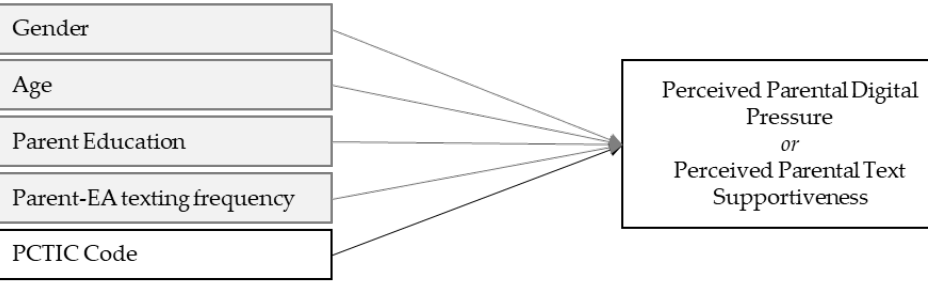
Figure 2. Q3 and Q4 Analytic Models. Note. Models were run separately for mother-emerging adult and father-emerging adult dyads. First, Perceived Parental Digital Pressure and Perceived Parental Text Supportiveness were regressed (in separate models) on parent-EA texting frequency and covariates of gender, age, and parent education (grey boxes/paths; results in upper panel of Tables 3 and 4). Next, Perceived Parental Digital Pressure and Perceived Parental Text Supportiveness were regressed (in separate models) on each PCTIC code separately, alongside covariates and parent-EA texting frequency (results in lower panel of Tables 3 and 4). Table 3. Associations Between Parent-Emerging Adult Texting Frequency and Content Codes with Emerging Adult Per- ceived Parental Digital Pressure.